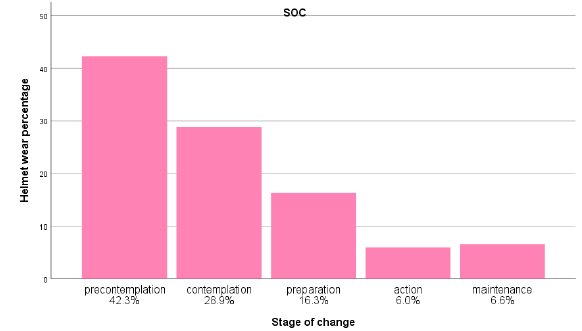
Figure 1. Distribution of participants across stages of behavior